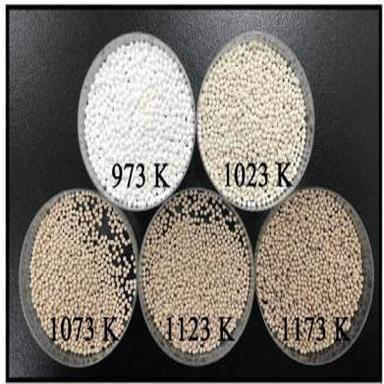
Photo of the pebbles sintered at different temperatures in air.